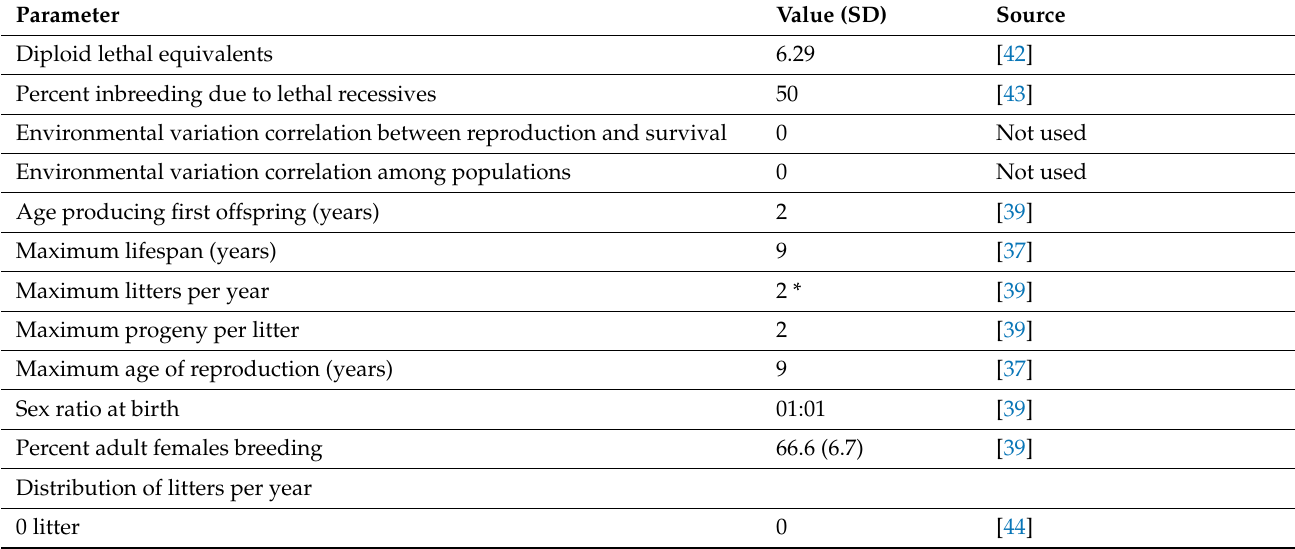
Table 2. Biological parameters used in Vortex simulations. The study that provided each parameter estimate is given. Parameter Value (SD) Diploid lethal equivalents Percent inbreeding due to lethal recessives Environmental variation correlation between reproduction and survival Environmental variation correlation among populations Age producing first offspring